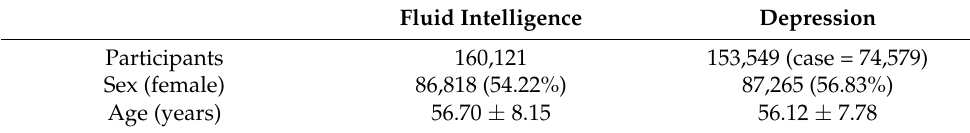
Table 1. Descriptive characteristics for fluid intelligence and depression